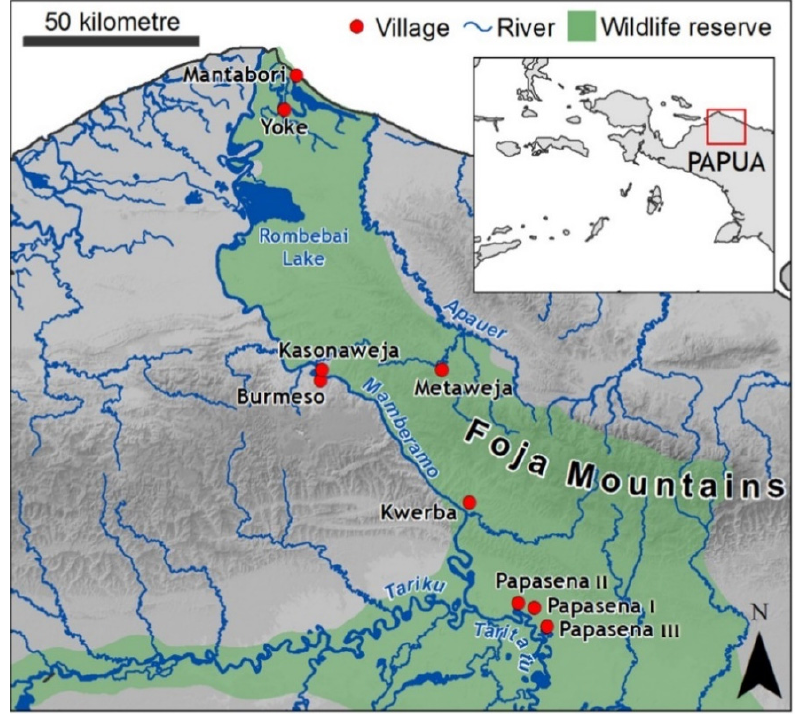
Figure 1. Location of the three settlements comprising Papasena and other notable settlements in the Mamberamo region, Papua, Indonesia. The main settlement, Papasena I, is located at UTM Zone 54M: E 231800 S 9677300. The green area denotes the area within the Mamberamo-Foja Wildlife Reserve. Map modified from that prepared by CIFOR’s Mohammad Agus Salim in Ref. [40] .